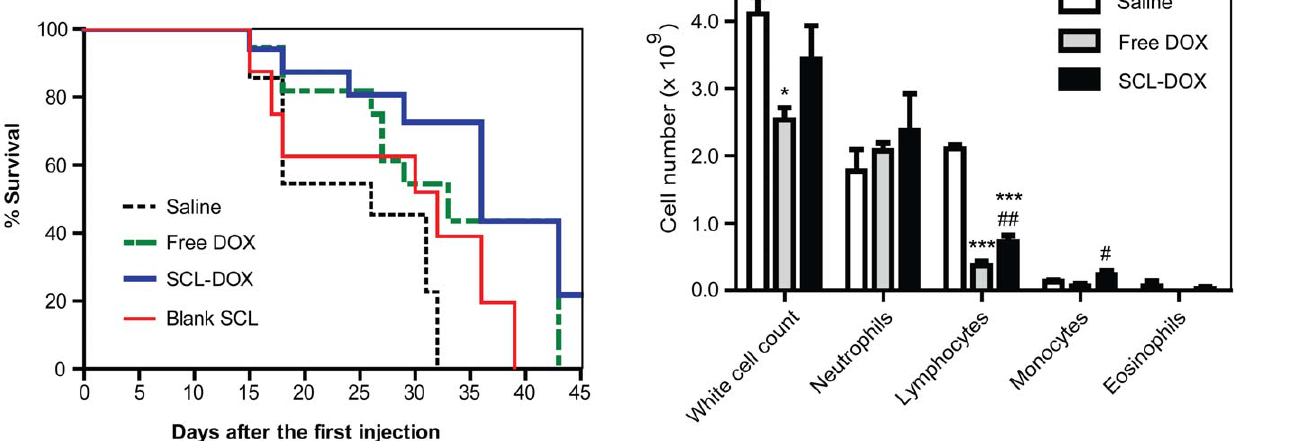
Figure 6. Sulfatide-containing liposomal doxorubicin treat- ment had significantly reduced myelosuppression. HT-29 xenograft-bearing mice were treated as indicated in Figure 3. Blood was collected immediately after the mice were sacrificed upon reaching the end point. Data shown are means 6 S.E. (n=3 , 5). *, P , 0.05 compared to saline; ***, P , 0.001 compared to saline; # , P , 0.05 compared to free DOX; ## , P , 0.01 compared to free DOX.